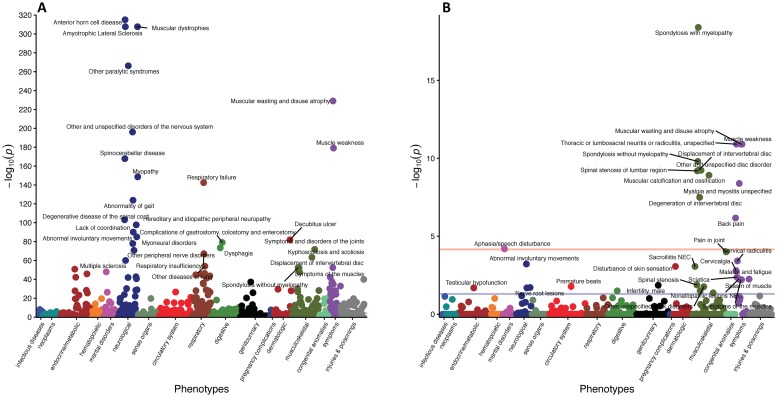
Manhattan plots of phenotypes with increased prevalence in SMA for Group C.(A) shows phenotypes with increased prevalence in SMA patients compared to controls throughout their entire coverage window. Only selected phenotypes with p-value<1e-47 are displayed. (B) Phenotypes with increased prevalence in SMA patients compared to controls from only data prior to their first sign of neuromuscular degeneration. Only phenotypes with p-value<0.021 are displayed. For both plots, the purple line represents an adjusted p-value of 5x10(-2) and the peach line represents an adjusted p-value of 5x10(-4). Completes lists of phenotypes are presented in the supplemental tables.